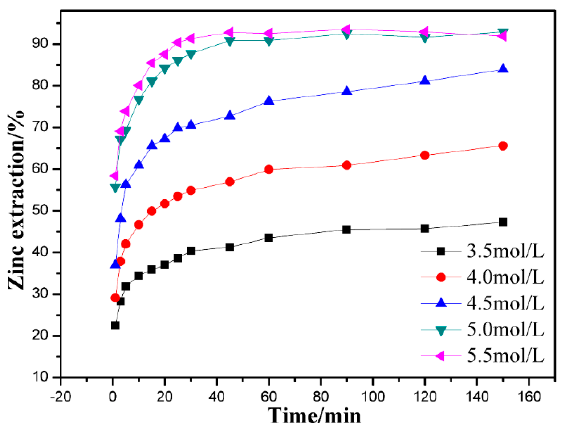
Figure 5. Effect of ammonia chloride concentration on zinc extraction (temperature, 95 °C; solid/liquid ratio, 5 g/L; stirring speed, 350 rpm; and particle size, 45–61 μ m).